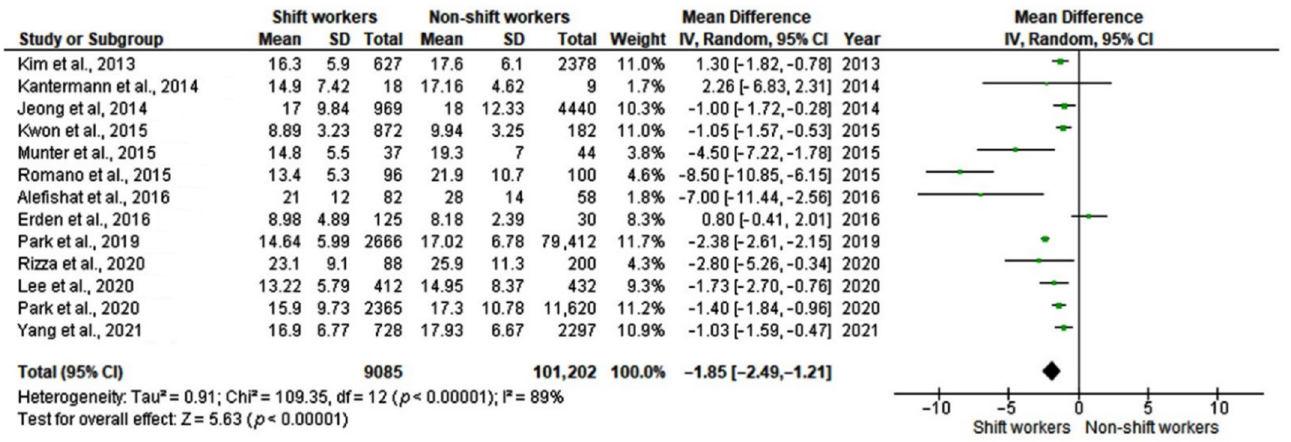
Figure 2. Forest plot showing mean differences in serum 25-hydroxyvitamin D (25-OH-D) levels (ng/mL) in shift workers and non-shift workers [12,24–35].